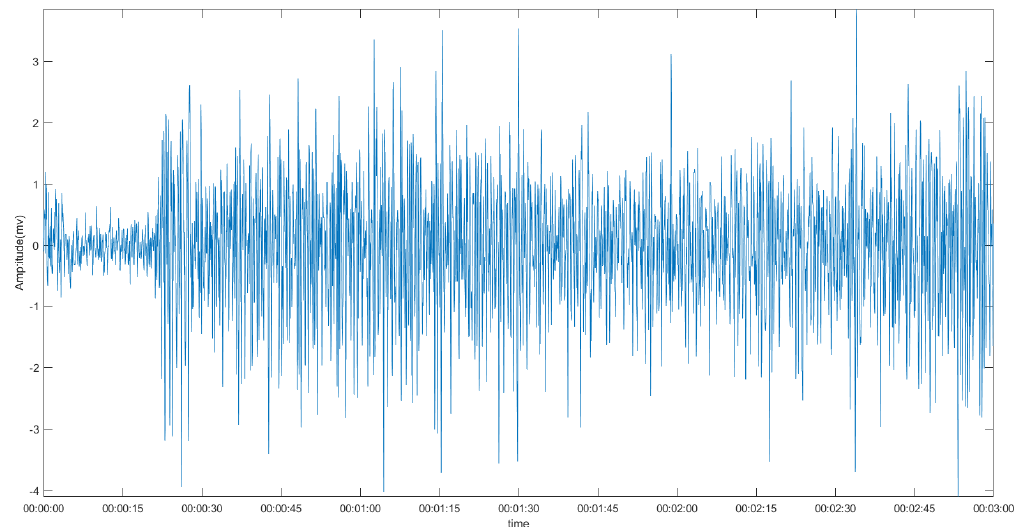
Figure 2. Example of a raw EMG signal.